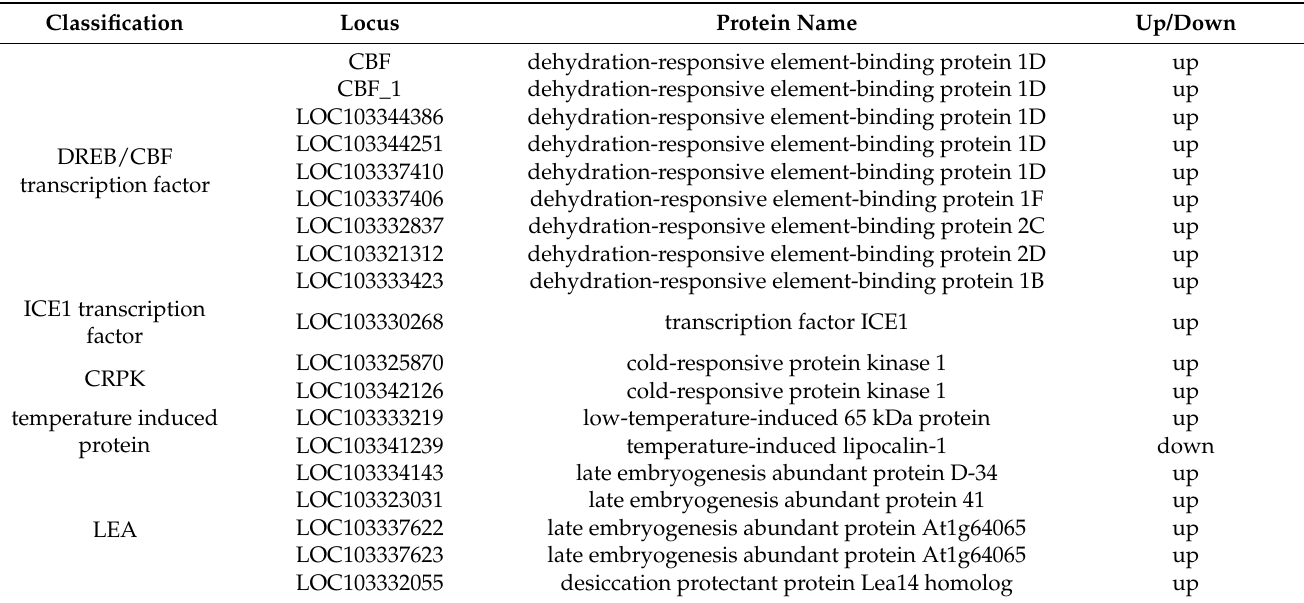
Table 2. The core genes related to cold stress in P. mume .